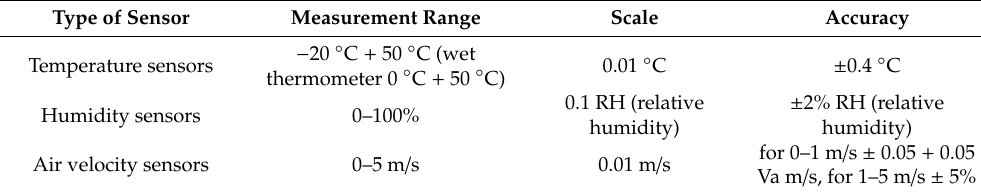
Table 4. Data from measurement